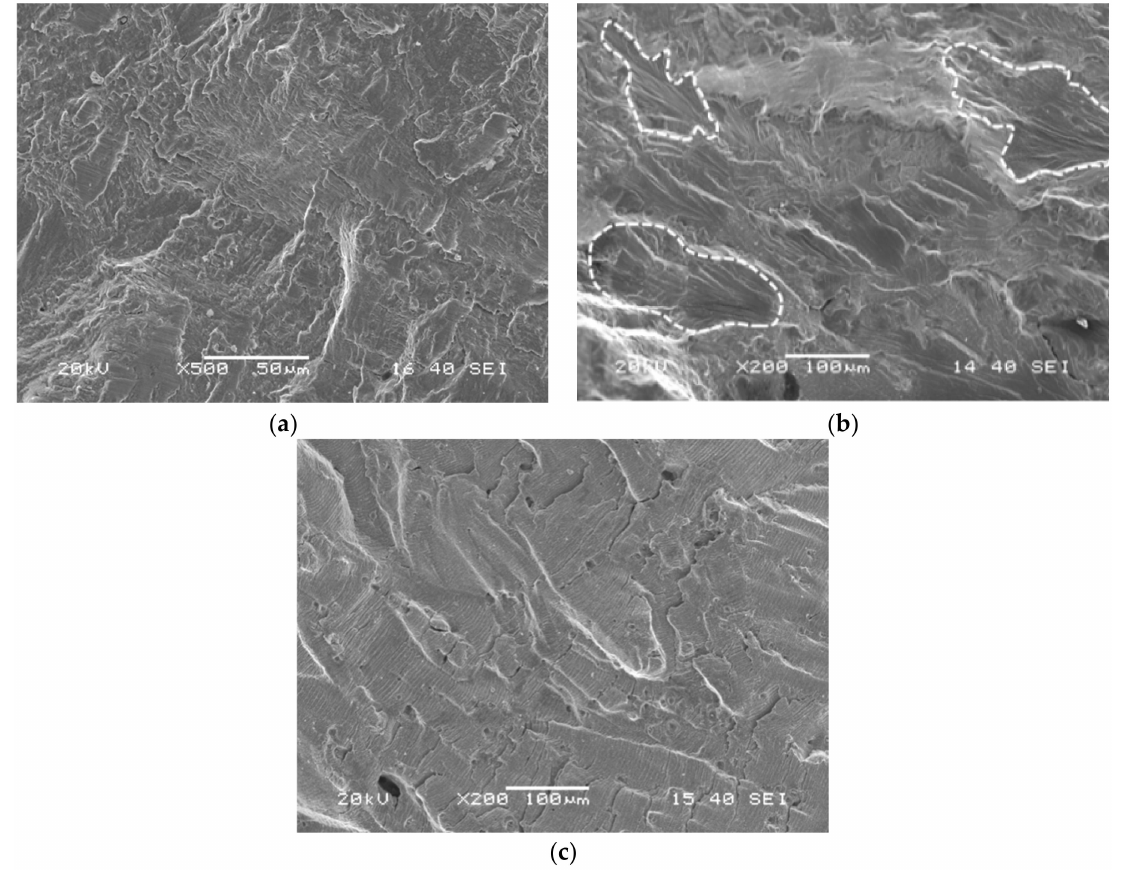
Figure 6. Fractured surfaces of Z3CN20.09M ASS at the strain amplitude of 0.8% and the strain rate of: ( a ) 0.4%/s in air at RT, ( b ) 0.4%/s and ( c ) 0.004%/s in high temperature